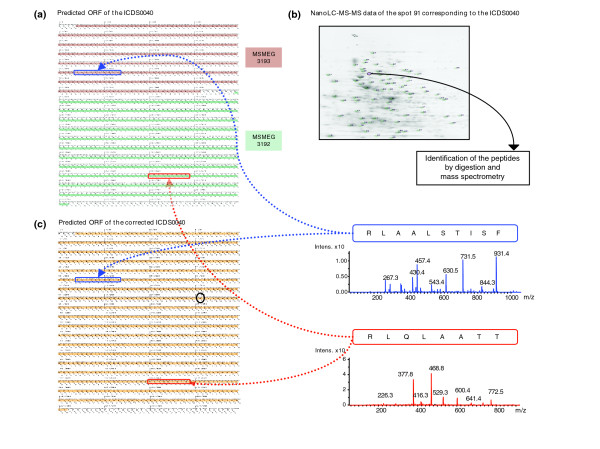
Comparison of genomic prediction with proteomic results (example of ICDS0040). (a) Representation of the DNA region and its predicted ORFs (in color). (b) Detailed view of the two-dimensional gel. Nano-LC-MS-MS data are obtained after extraction and digestion of the protein. The matching peptides are boxed in the translated genomic sequence (a,c). (c) Representation of the DNA region and its predicted ORF upon correction of the sequencing errors (depicted in the ellipse). Correction of the sequencing errors reassociates the two peptides to give a single protein, accounting for their appearance at a single spot.